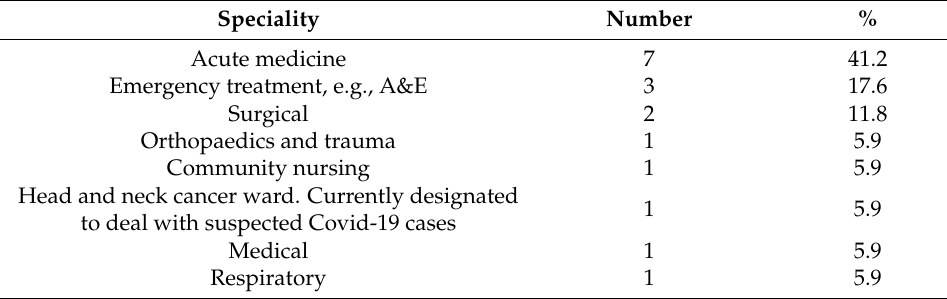
Table 4. Paid placement speciality.